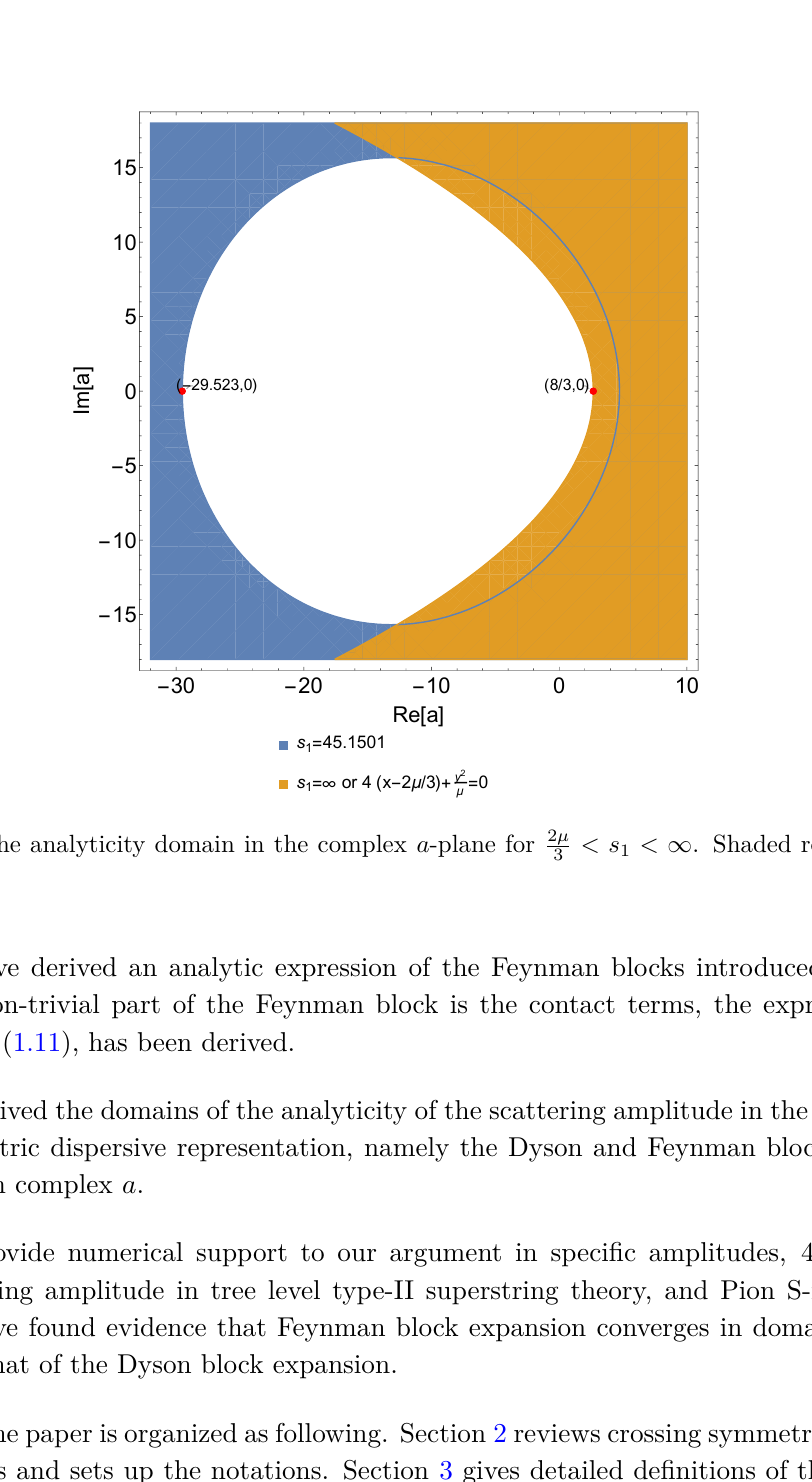
< s 1 < ∞ . Shaded regions are 3